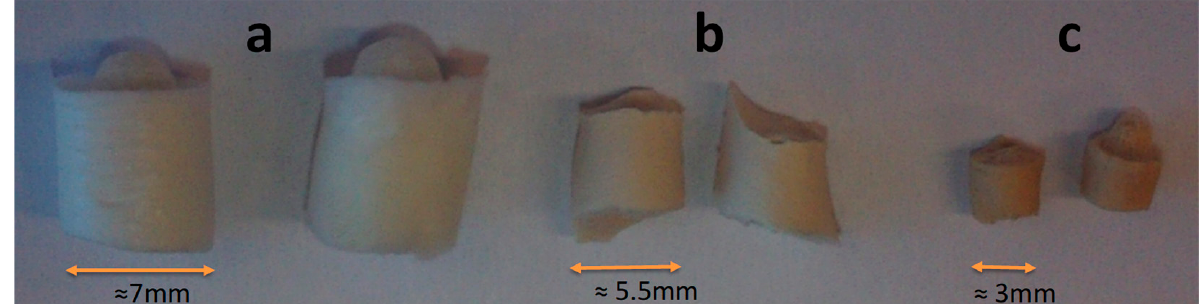
Figure 2. Photo of DDA-Gel 1:3 samples after incubation at high humidity and following drying in desiccator at room temperature: ( a ) initial gel, ( b ) after 93% RH, ( c ) after 100% RH.